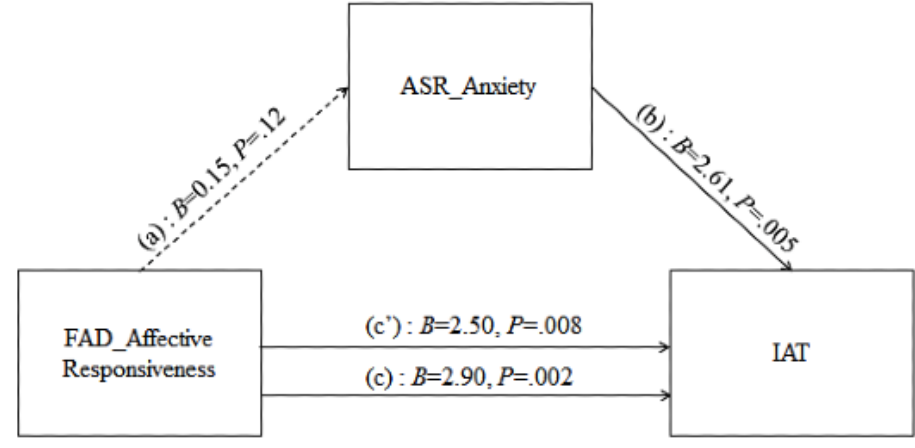
Figure 2. Simple mediation model for anxiety problems mediating the association between affective responsiveness and internet addiction. (a) Direct effect of affective responsiveness on anxiety problems; (b) direct effect of anxiety problems on IAT score; (c’) direct effect of affective responsiveness on IAT score; (c) total effect (a*b+c’) of affective responsiveness on IAT score. ASR: Adult Self-Report; FAD: Family Assessment Device; IAT: internet addiction test.